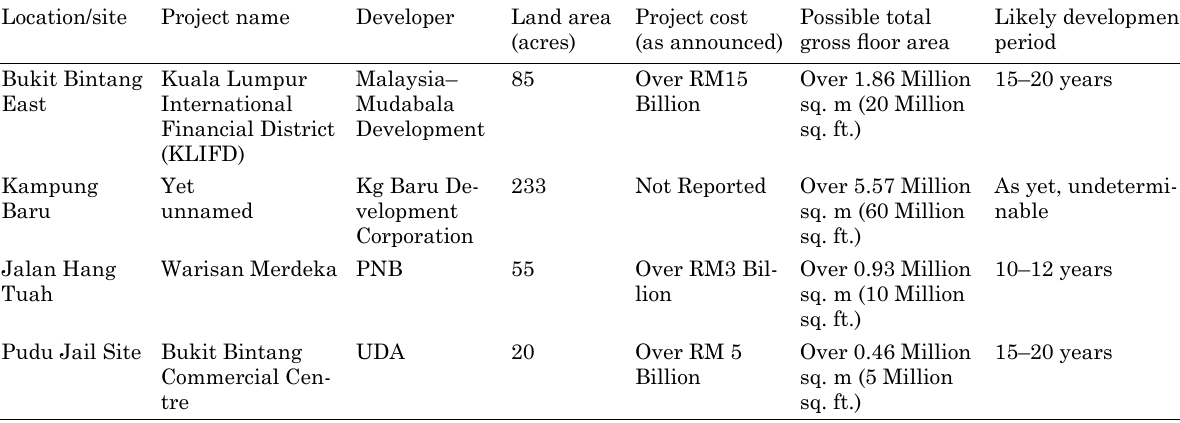
Table 1. The commercial projects planned within Kuala Lumpur city centre